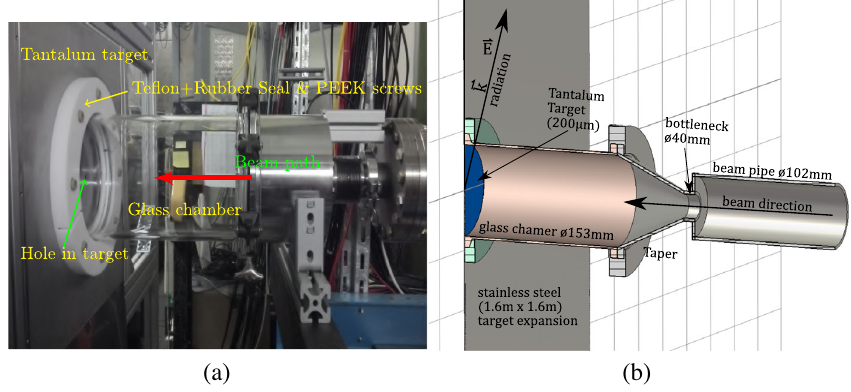
FIG. 15. (a) Photo of the first prototype setup. (b) The simulation model of the setup (cross section).